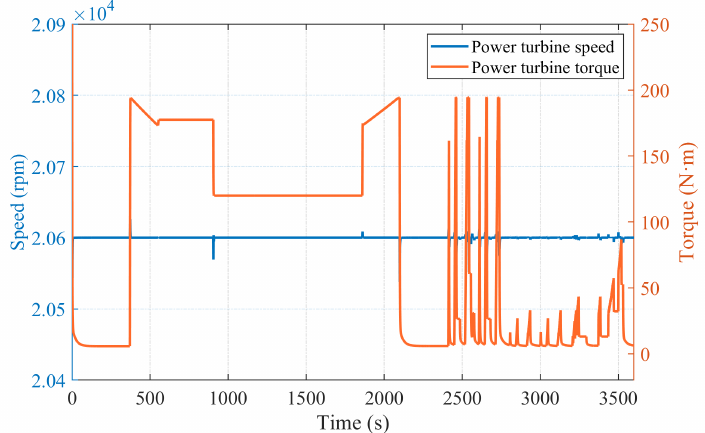
Figure 16. Speed and torque response curves of power turbine in the turboshaft engine.